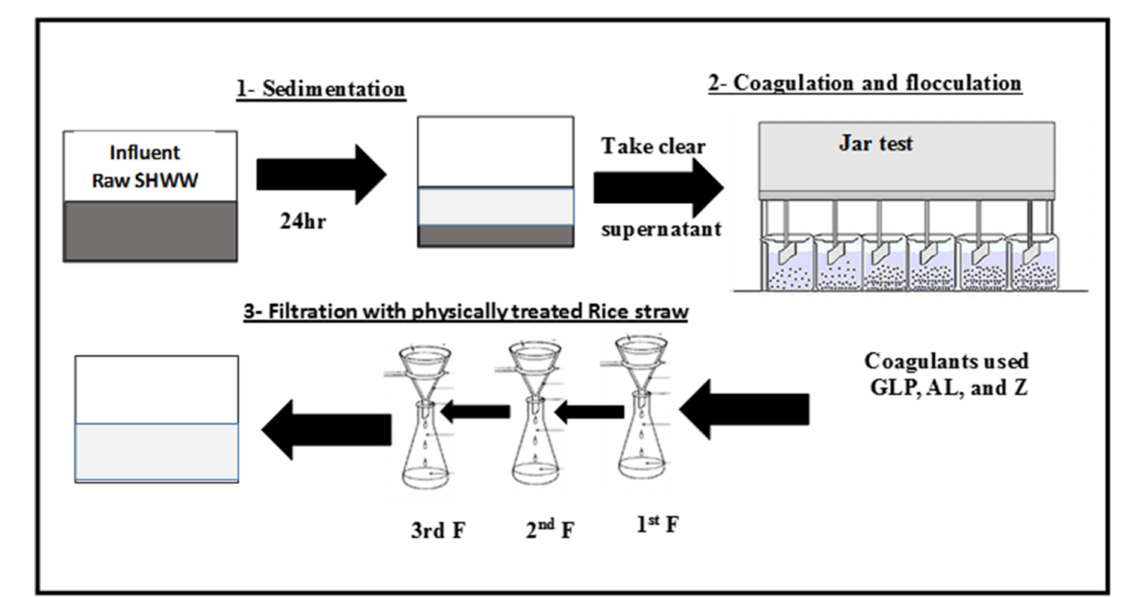
Figure 1. Lab-scale of SHWW treatment